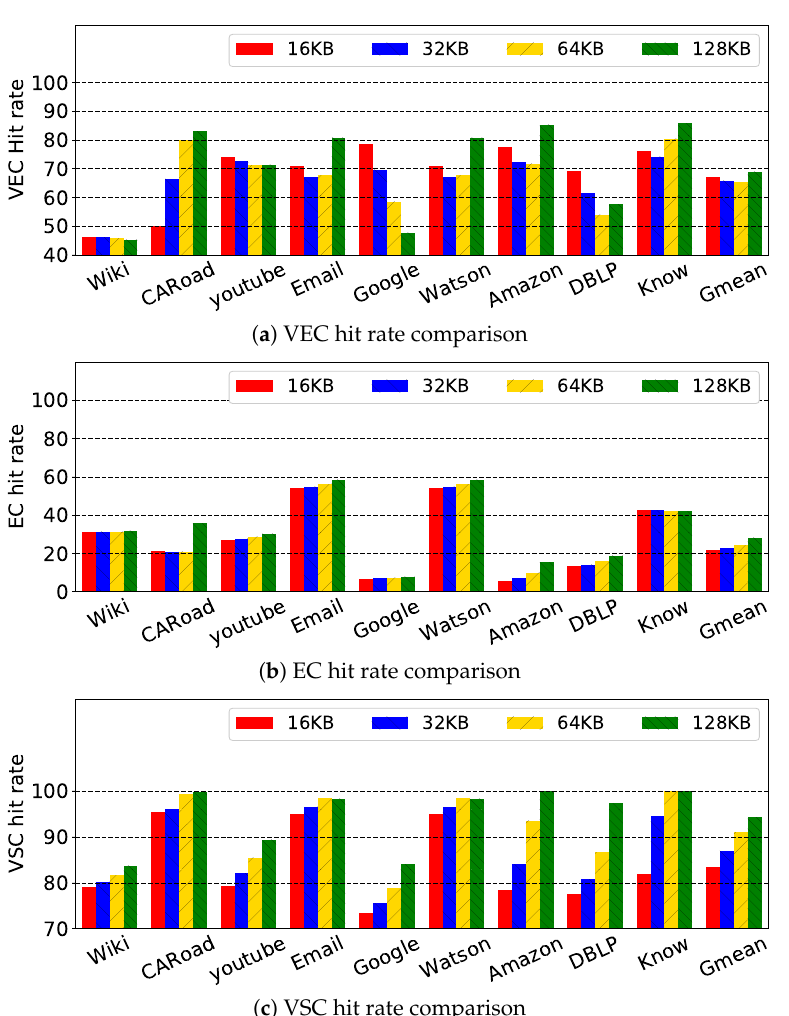
Figure 14. Comparison of the on-chip cache hit rate for different on-chip cache capacities.